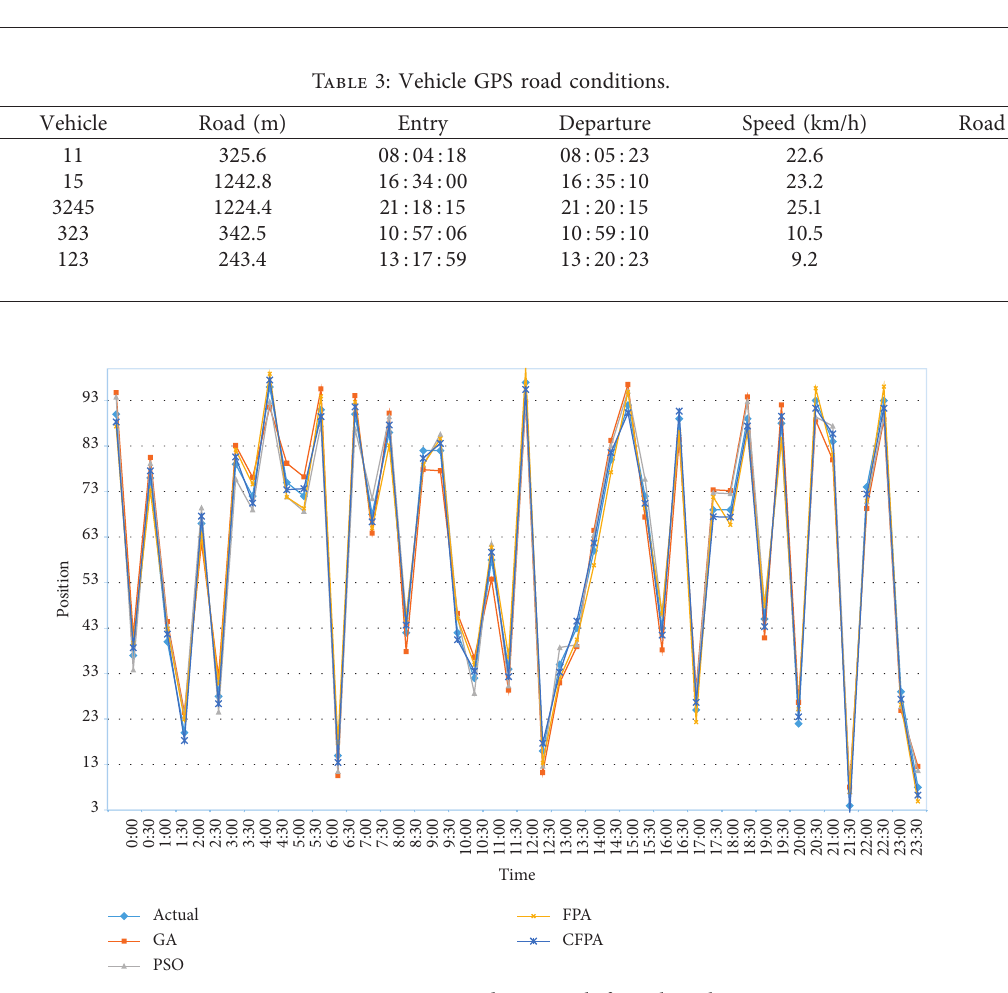
Figure 6: GPS position prediction with four